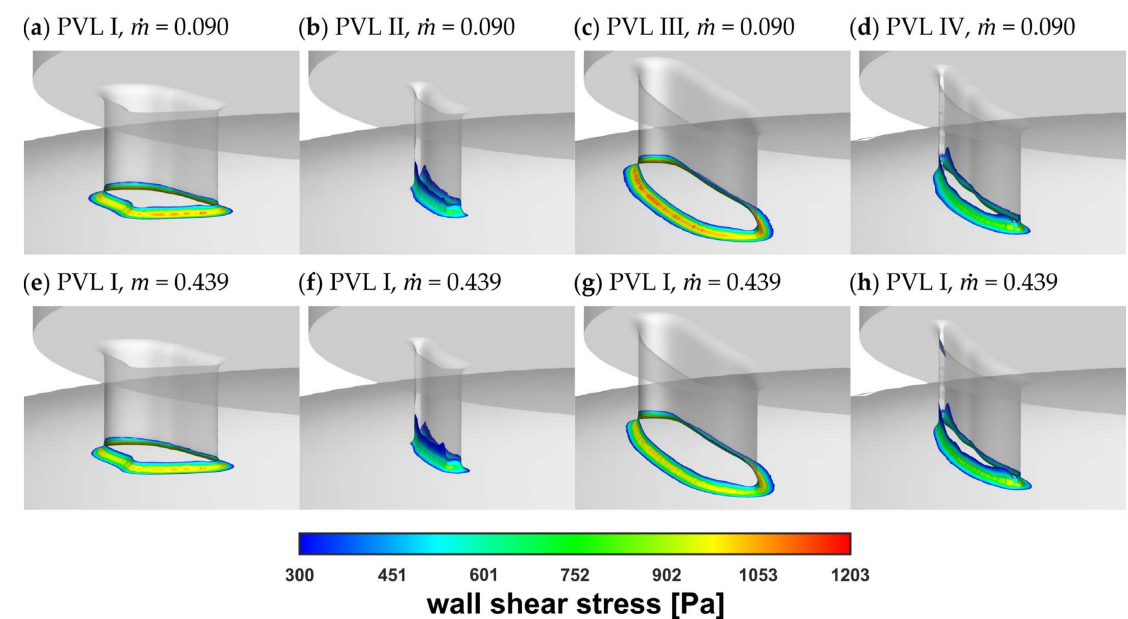
. m = 0.090 kg s − 1 ; ( e – h )